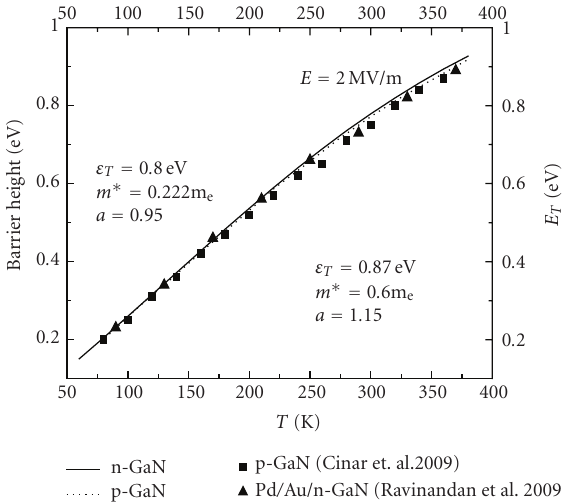
Figure 7: Variation of the barrier height with temperature for Pd/Au/n-GaN from [12] and Ag/p-GaN [14] (symbols), fitted to the E T versus T exposed by solid line for n -type and dot line for p-type GaN.